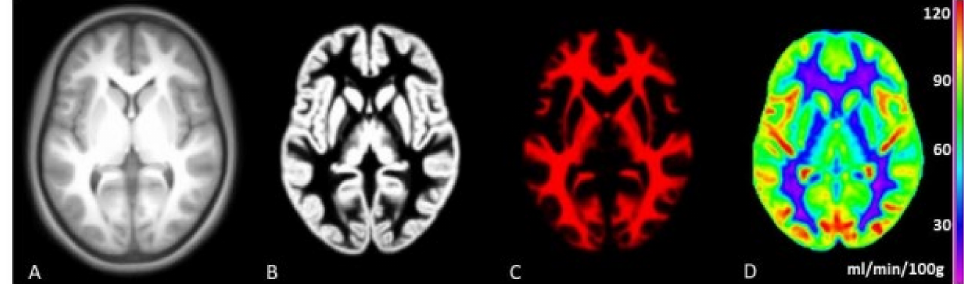
Figure 1. ExploreASL workflow This figure demonstrates several stages of the ExploreASL work flow to calculate a cerebral blood flow (CBF) map. ( A ) = a structural 3D T1 scan. ( B ) = a segmented gray matter map. ( C ) = segmented white matter map. ( D ) = a CBF map. There were no statistically significant hematocrit differences, adjusted for age and sex, between PHIV adolescents and controls ( p = 0 .496); hence we assumed the same blood T1 value for all